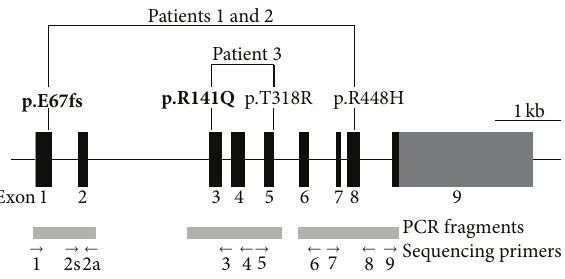
Figure 3: Schematic diagram of the human CYP11B1 gene showing positions of mutations identified in this study. The two novel mutations, p.E67fs (c.199delG) in exon 1 and p.R141Q (c.422G > A) in exon 3, are indicated in bold